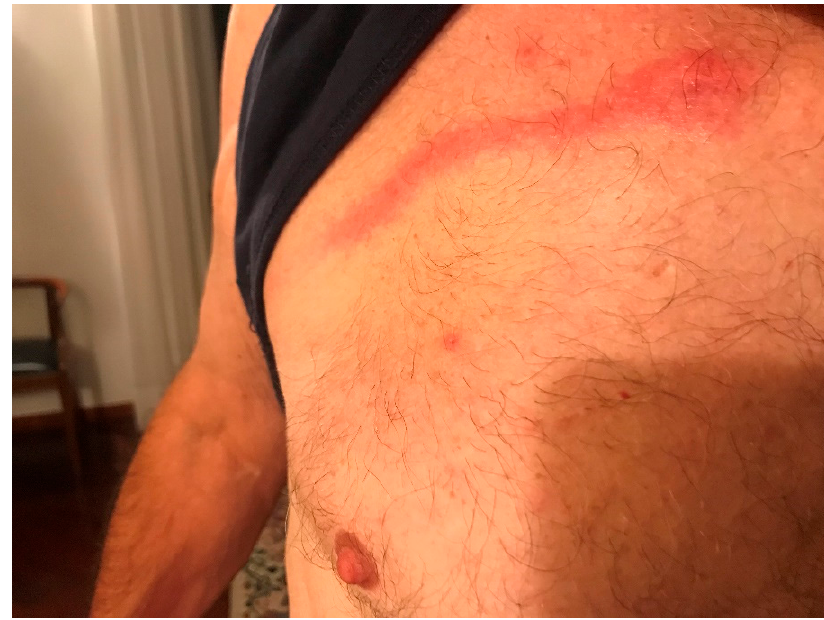
Figure 1. Pyemotes ventricosus dermatitis with classical comet sign.